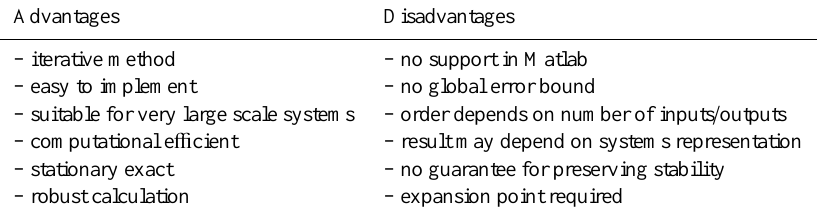
Table 2. Characteristics of Krylov subspace methods.